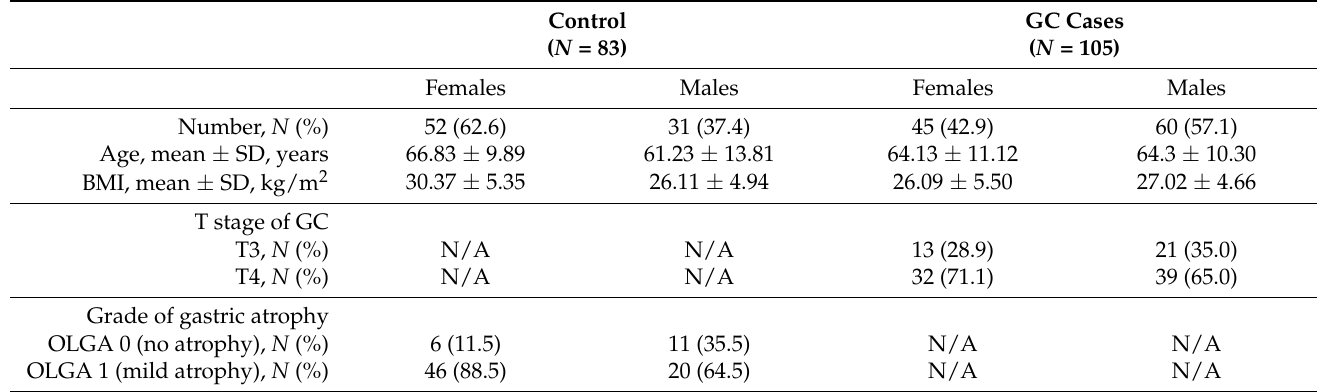
Table 1. Descriptive statistics of the study